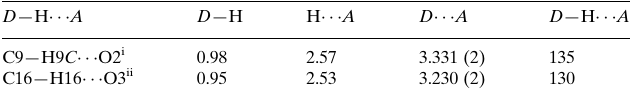
Hydrogen-bond geometry (A˚ , (cid:2)